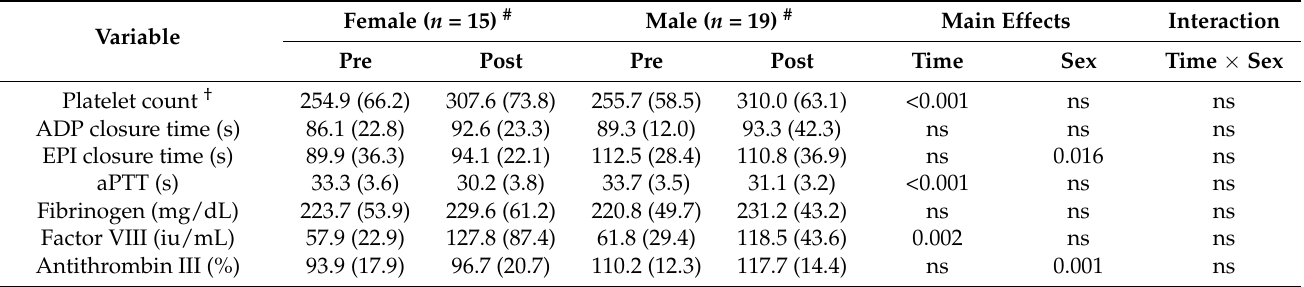
Table 3. Platelet, coagulatory responses, and fibrinolytic responses to firefighting activities for male and female firefighters. Values presented as mean (standard